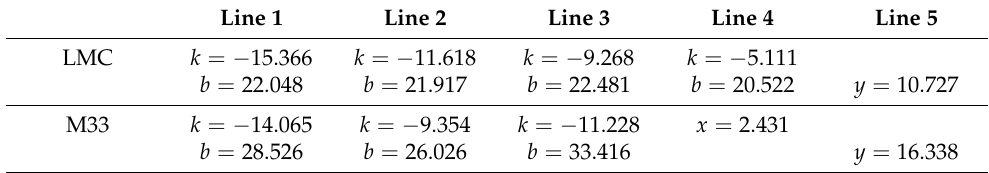
Table 2. The coefficients of borderlines in the ( J − K ) 0 / K 0 diagram of LMC and M33. Line